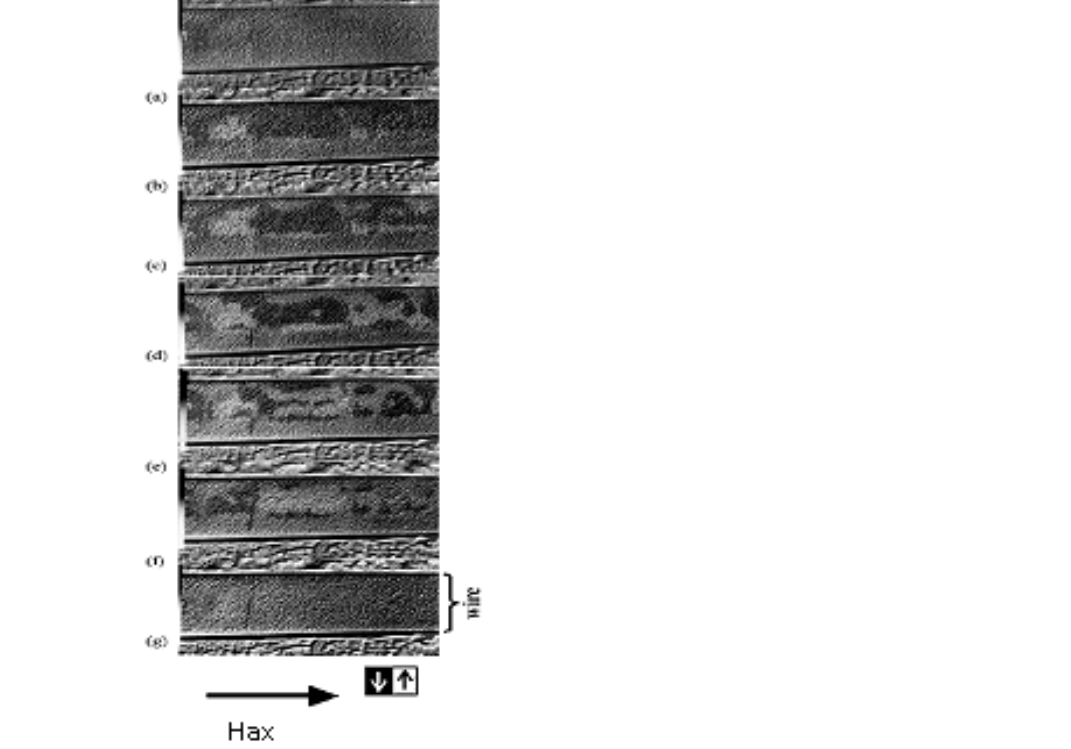
Figure 2. Surface magnetic domain structures transformation in wide wedge. ( a ) − 10 Oe, ( b ) − 2 Oe, ( c ) − 0.8 Oe, ( d ) − 0.4 Oe, ( e ) 0.14 Oe, ( f ) 2 Oe, ( g ) 10 Oe. Reprinted with permission from [88].